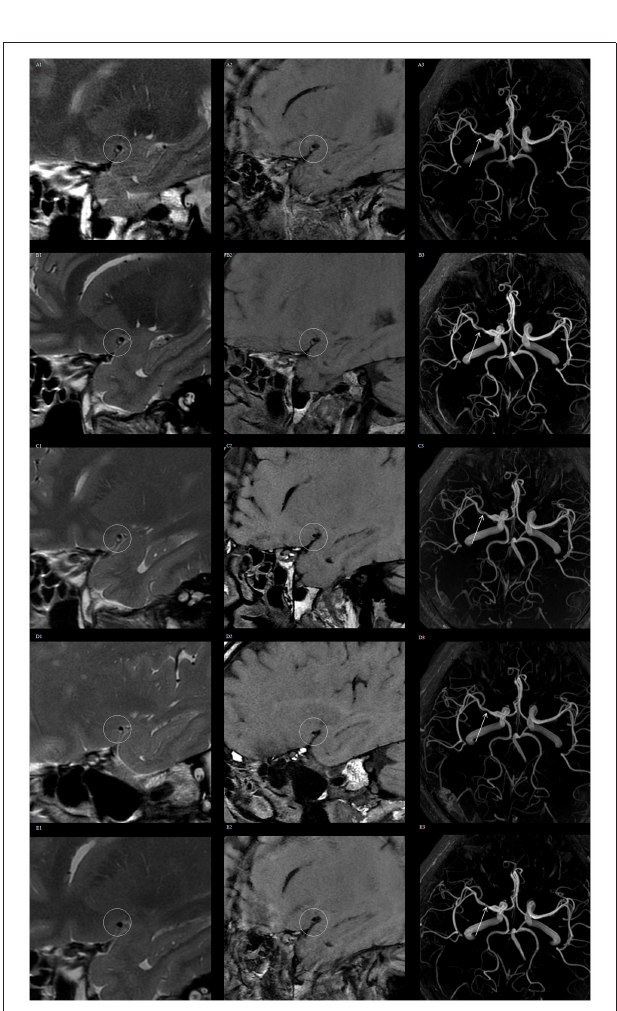
FIGURE 1 | Vessel wall magnetic resonance imaging (VWMRI) of plaque changes in the right middle cerebral artery (MCA) of a patient during the follow-up period. VWMRI and MRA show no significant changes in plaque volume and luminal stenosis at baseline, 1, 3, and 6 months. The plaque volume and luminal stenosis degree were reduced at the 12-month follow-up time point. Baseline, 1-, 3-, 6-, and 12-month 3D CUBE T2 images (A1–E1) , 3D CUBE T1 sequence images (A2–E2) , and 3D TOF MRA images (A3–E3) .